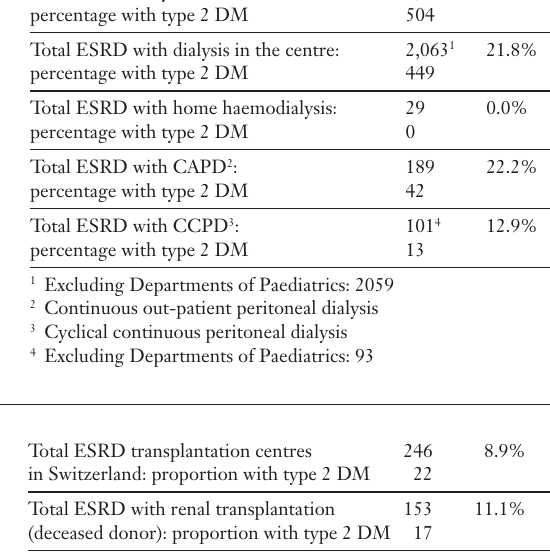
Transplantation cen- tres in Switzerland: total ESRD, percent- age of ESRD with type 2 DM and mode of treatment (assessed between 1 January 2001 and 31 December 2001).